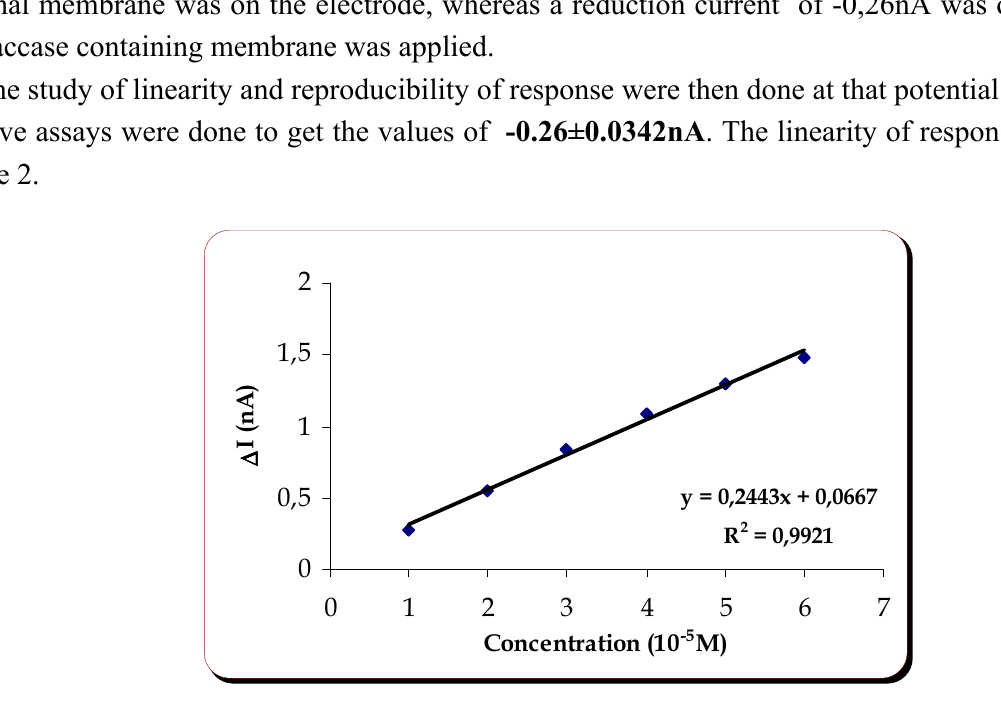
Figure 2. Linearity of response of the laccase containing biosensor to